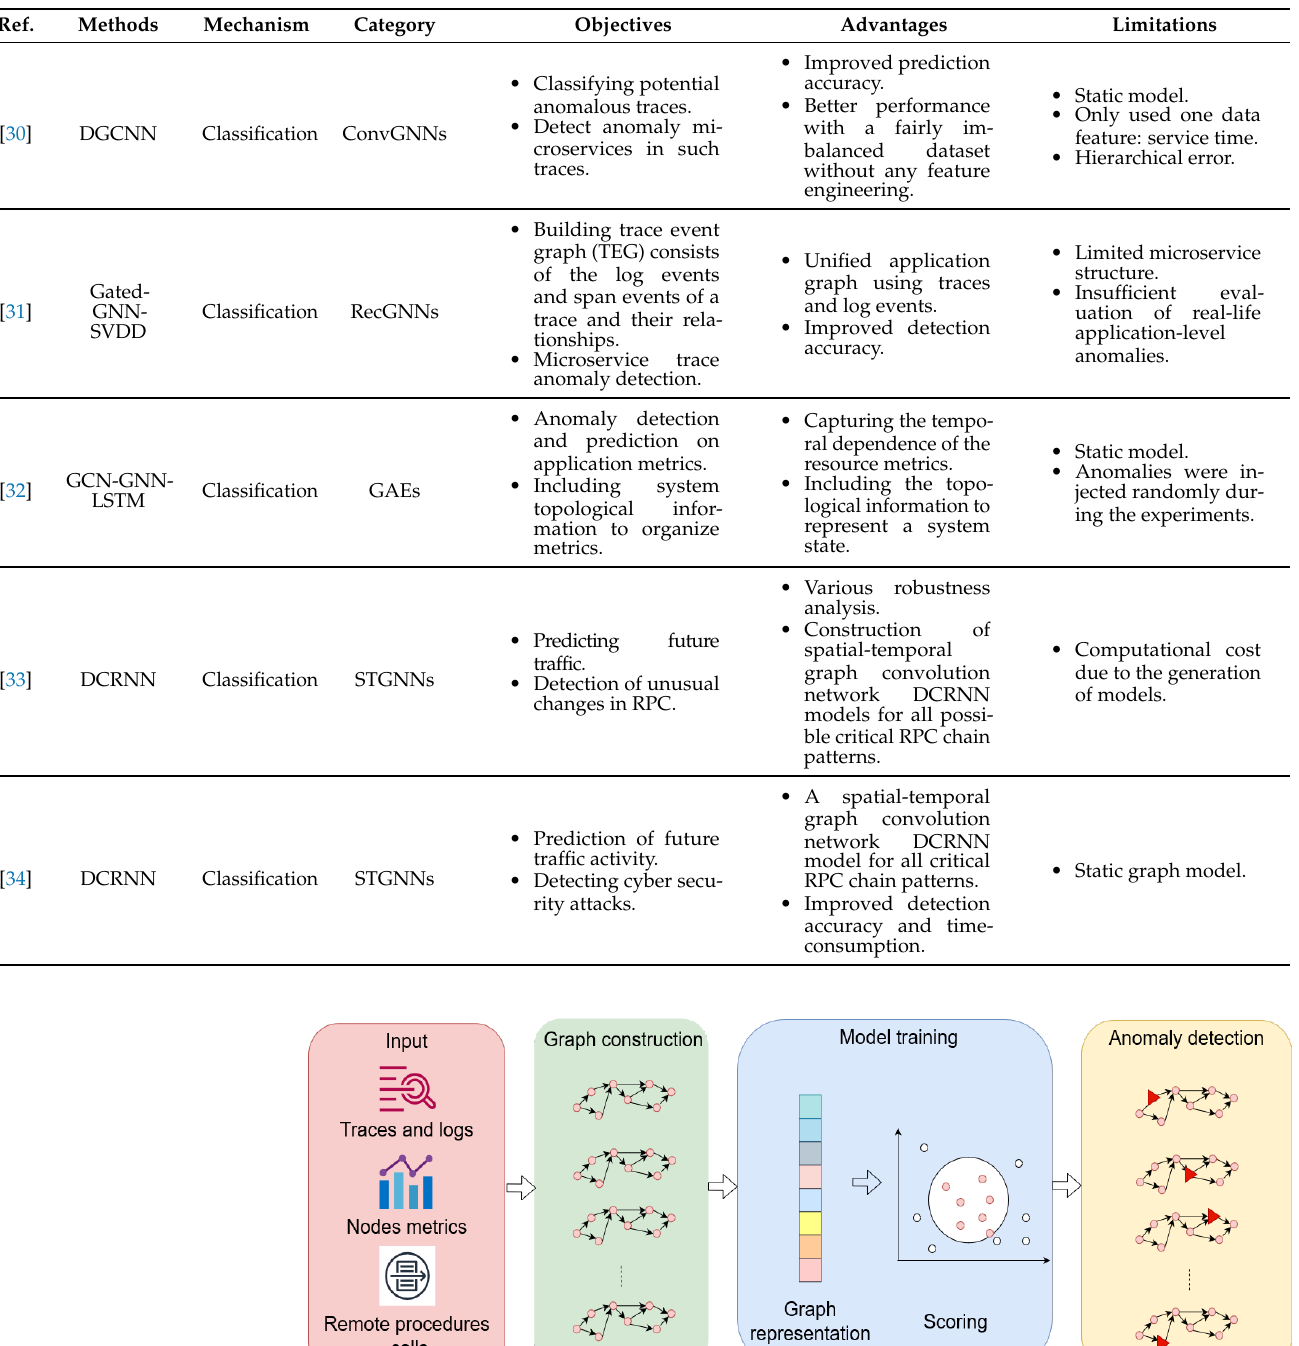
Table 5. Summary of anomaly-detection approaches.